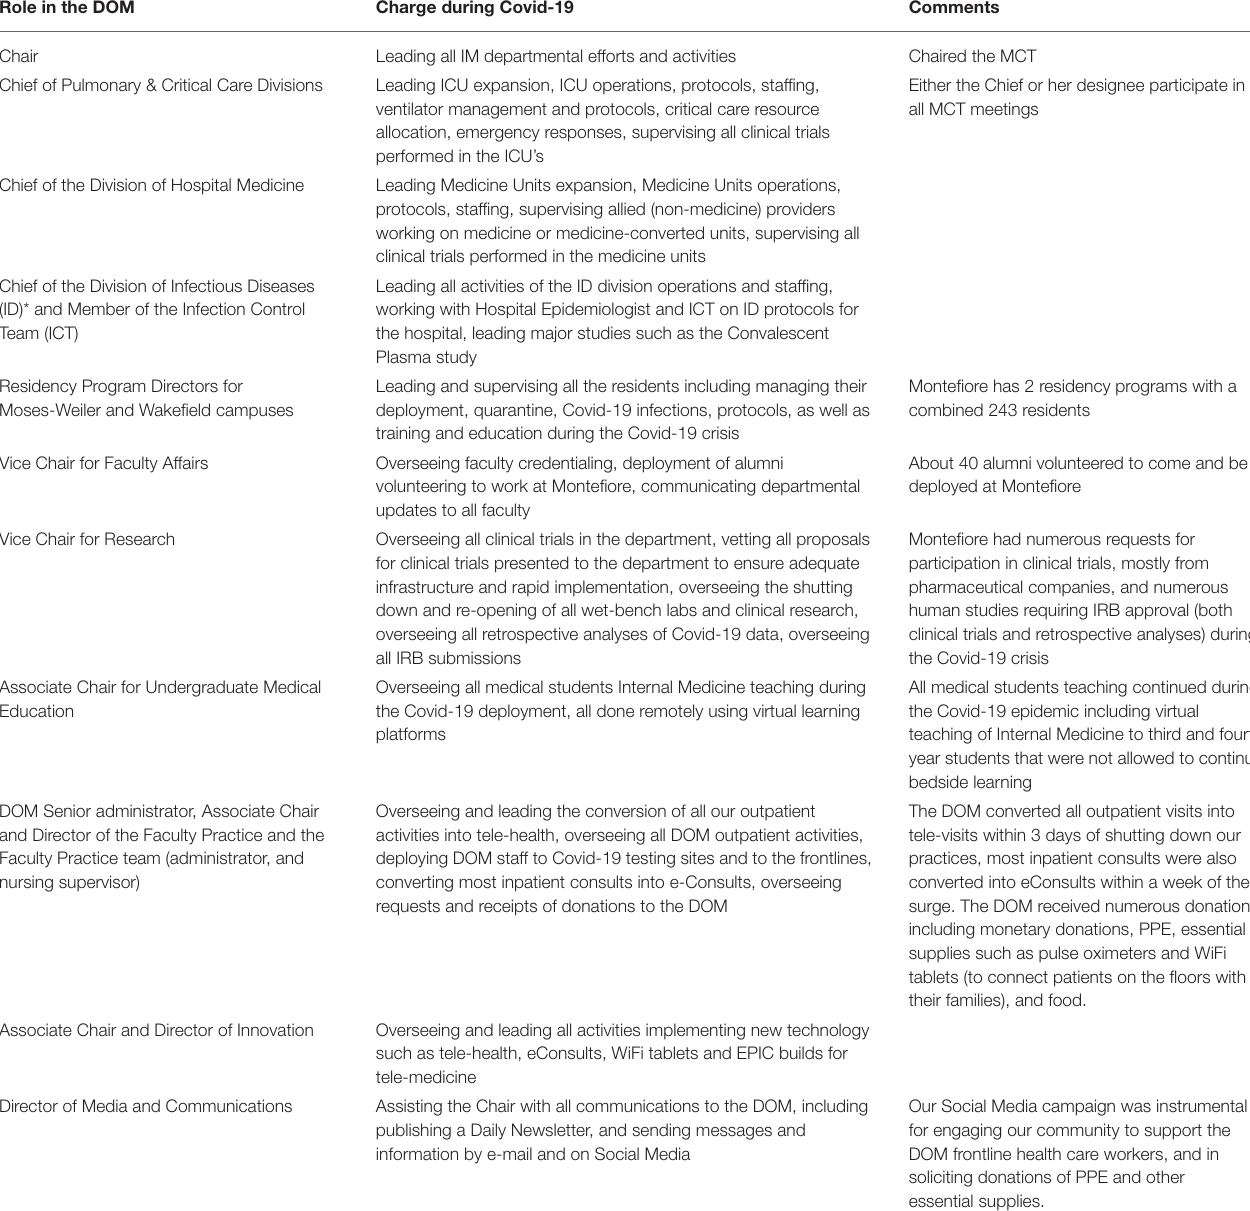
TABLE 2 | Members of the medicine covid-19 taskforce and their roles in coordinating DOM efforts and initiatives. Role in the